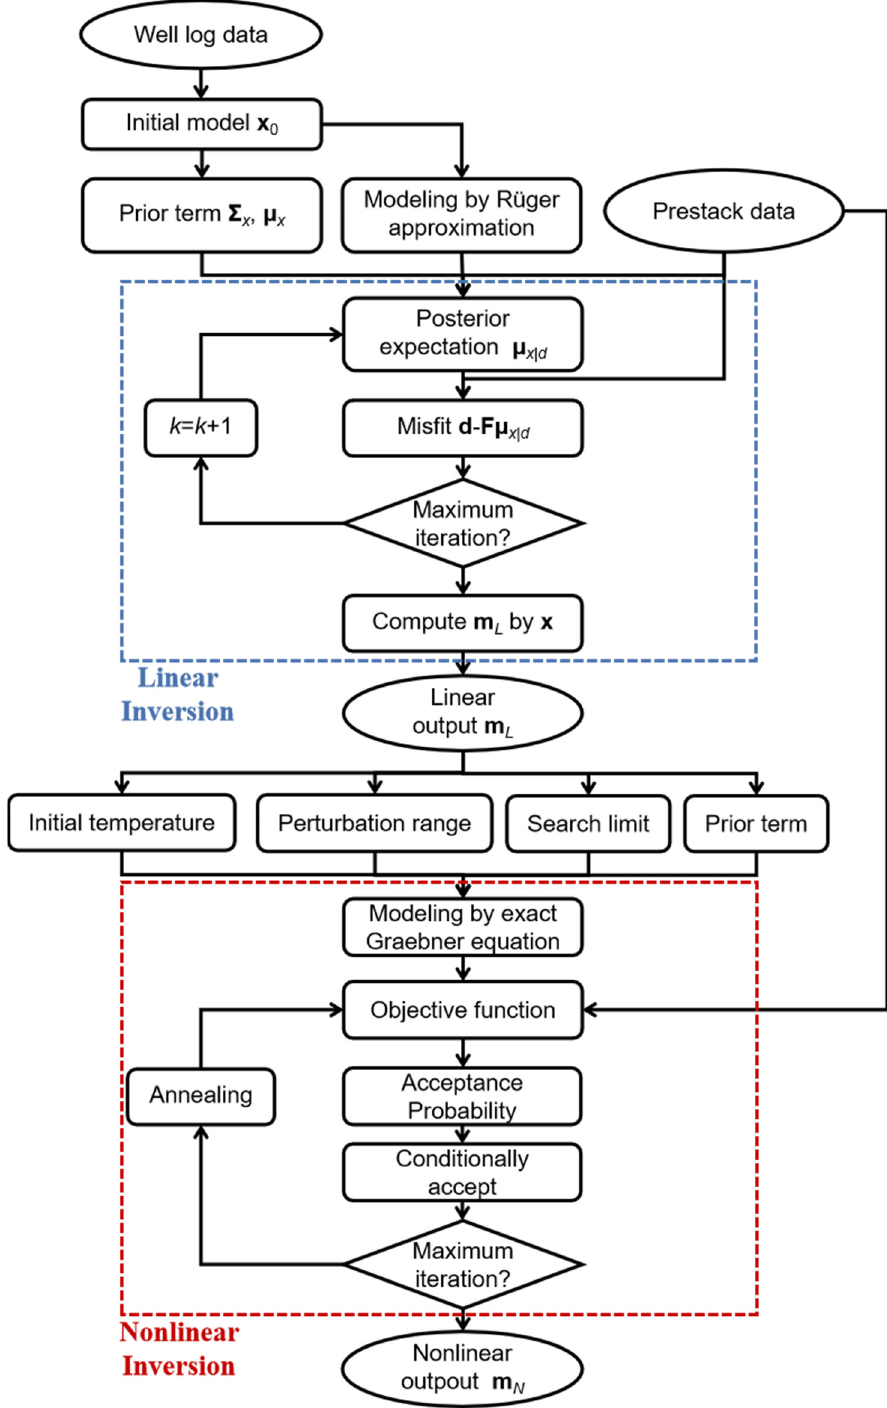
Figure 1. Flowchart of the proposed sequential seismic anisotropic inversion based on the FSA al- gorithm with the adaptive se tt ing of optimization parameters. algorithm with the adaptive setting of optimization